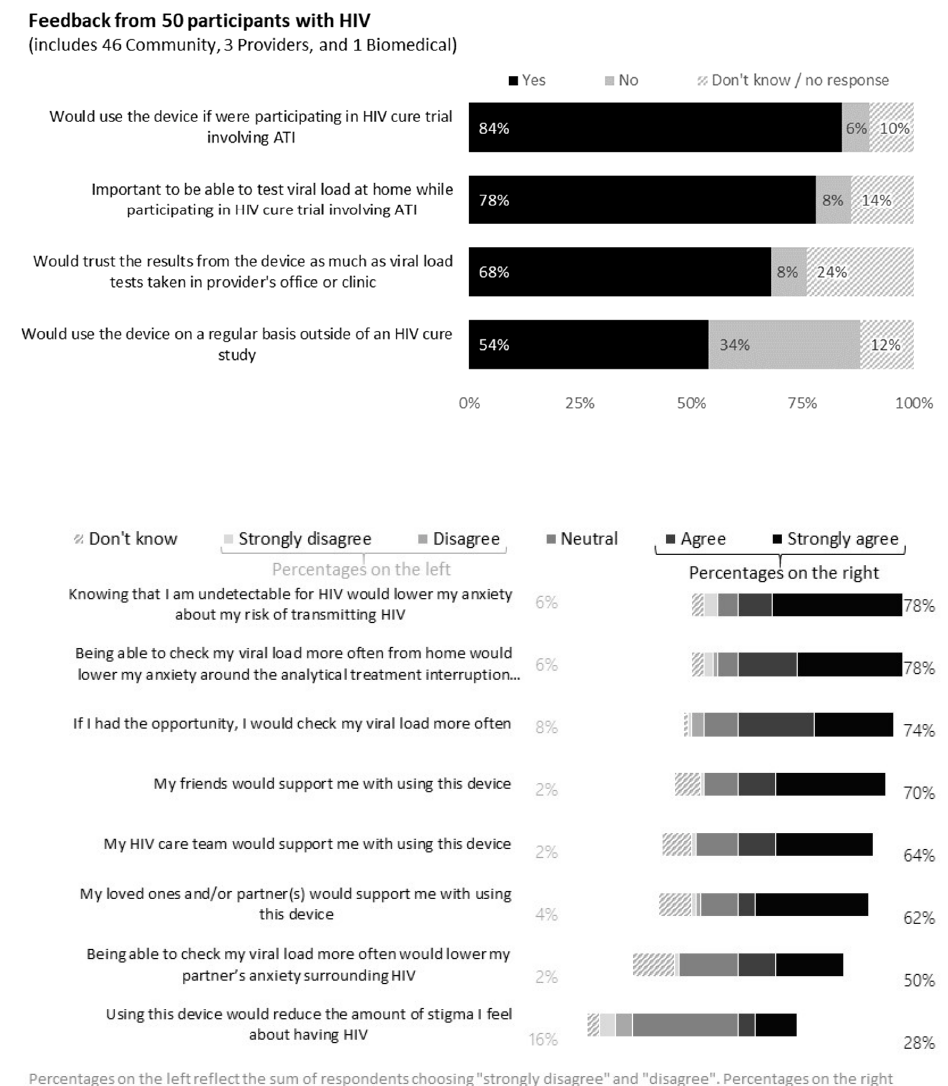
Figure 6. Feedback from 50 persons with HIV (United States, 2021).